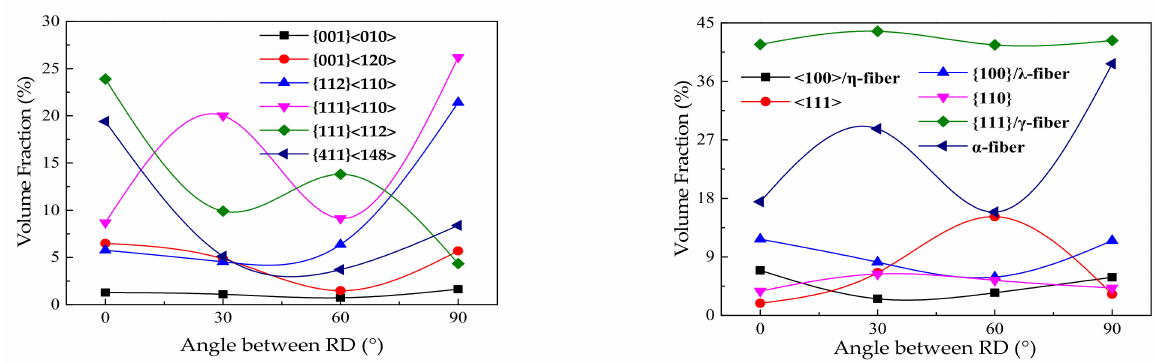
Figure 8. Texture in each direction of Fe-0.65%Si non-oriented electrical steel annealed